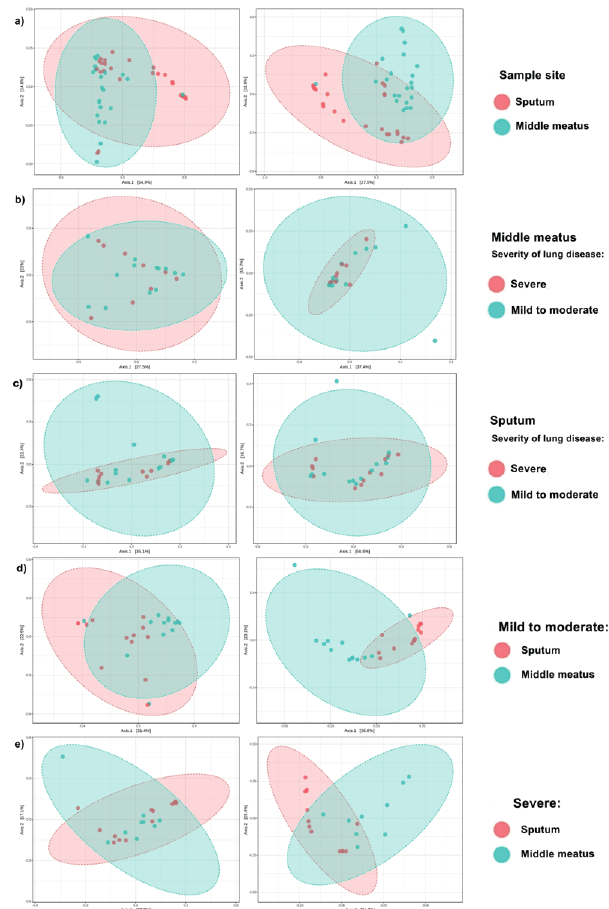
Figure 4. Principal coordinate analysis (PCoA) from sample site and from disease severity. Weighted analyses were plotted according to the more abundant genera (left) and unweighted analyses were plotted accord- ing to all bacteria genera (right): a) by sample site (weighted: p <0.001; unweighted: p <0.001); b) by disease severity in the middle meatus sam- ples (weighted: p = 0.99; unweighted: p = 0.82); c) by disease severity in the sputum samples (weighted: p = 0.28; unweighted: p = 0.92); d) by sample site in mild/moderate disease (weighted: p < 0.001; unweighted: p < 0.001); and e) by sample site in severe disease (weighted: p < 0.001; unweighted: p < 0.001). This result expresses the microbial community structure in (a) each site, (b) and (c) sample site according to disease state, (d) and (e) disease state according to sample site. There were sig- nificant differences (p<0,001) in microbial community in each sample site (a), and in each sample site according to disease state (d and